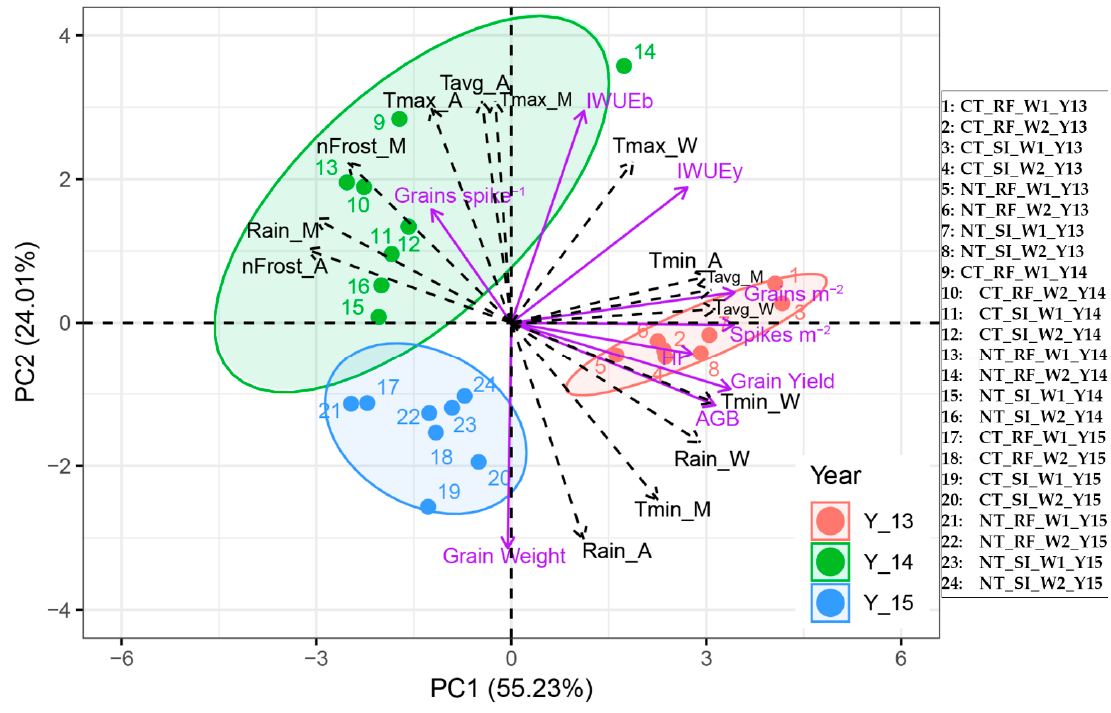
Figure 2. Principal component loading plots and scores of principal component analysis for dry biomass (AGB), yield, yield components and irrigation water use efficiencies (IWUE b , IWUE y ) in wheat as function of year, agronomic management, water regime and cultivar.